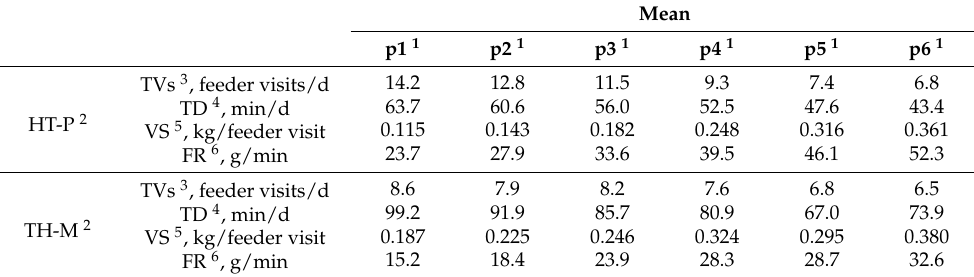
Table 2. Mean of the feeding behaviour habits by trial and period.